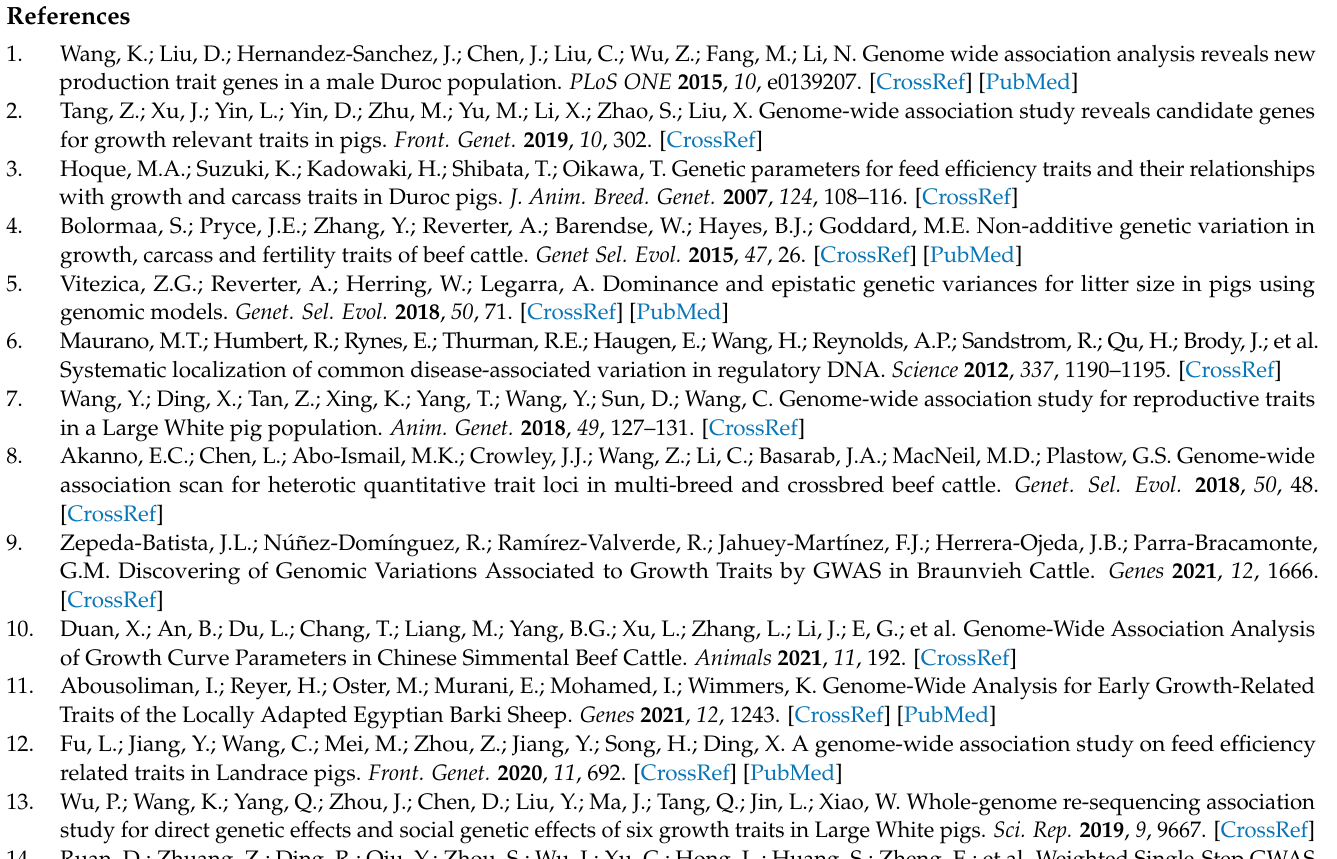
information; Figure S8: Sub-network 2 for LMD and the LD information; Figure S9: Sub-network 3 for LMD and the LD